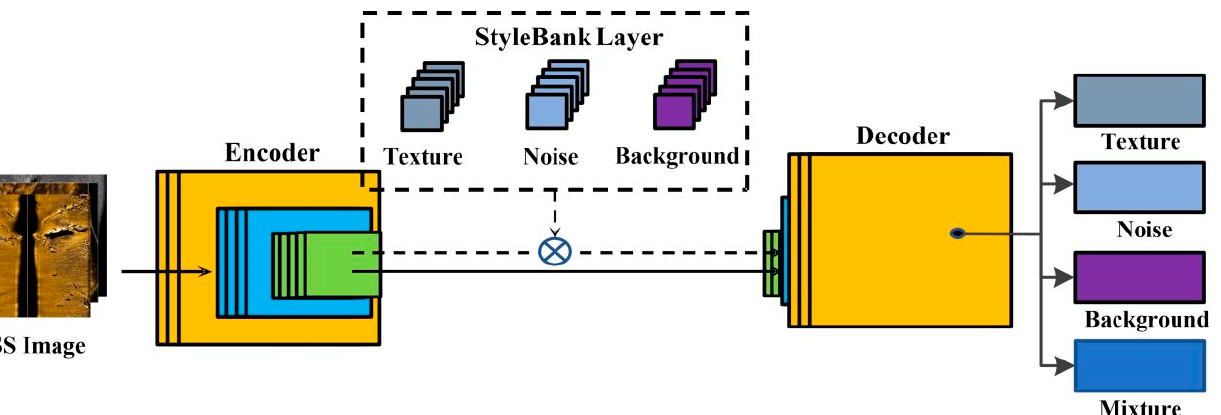
Figure 9. Shadow generation.